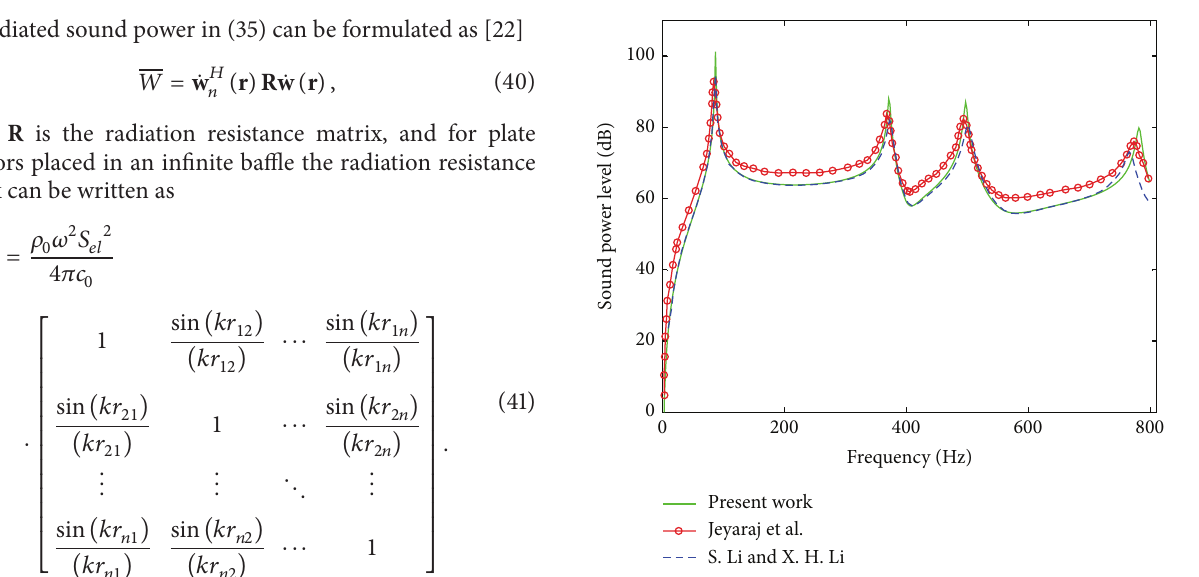
Figure 5: Comparisons of sound power level of an isotropic plate with Jeyaraj et al. [5] and S. Li and X. H. Li [39].